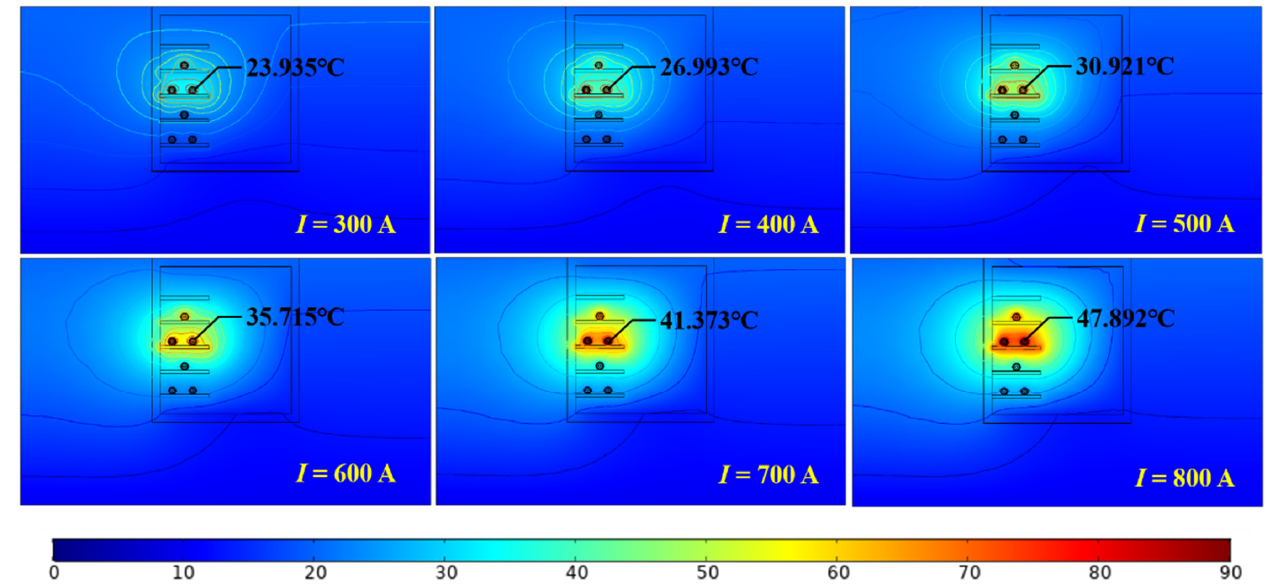
Figure 4. The cable trench temperature distribution under different load currents I.